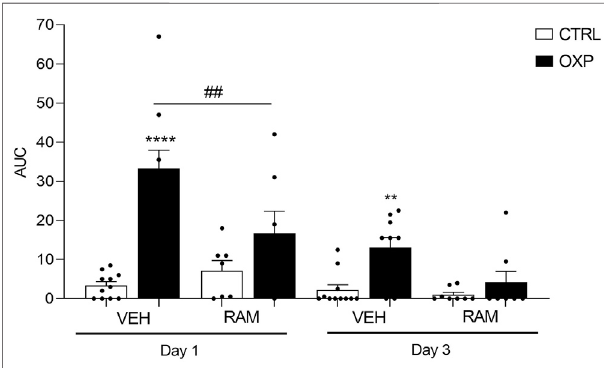
FIGURE 5 | Effects of ramipril on OXP-induced cold hypersensitivity. Results are compared using mixed-effects model test followed by Tukey ’ s multiple comparisons test (Factor treatment: F 5, 47 (cid:1) 15.57, p < 0.0001, time: F 1, 45 (cid:1) 38.68, p < 0.0001 and interaction: F 5, 45 (cid:1) 4.621, p (cid:1) 0.0017). Each group represents the mean of 8 – 10 animals, and the error bar